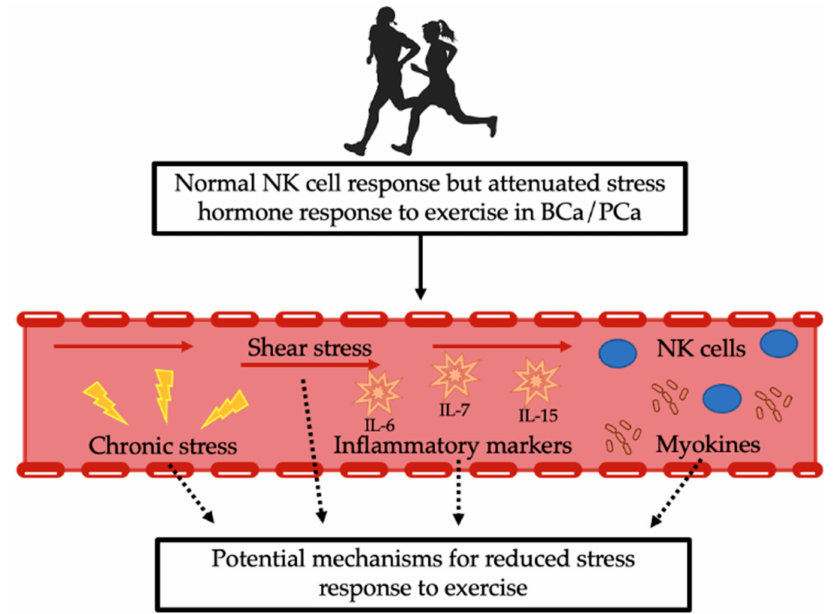
Figure 2. Hypothesized mechanisms that compensate for the attenuated stress hormone response following acute exercise that permits normal NK mobilization in breast (BCa) and prostate cancer (PCa)